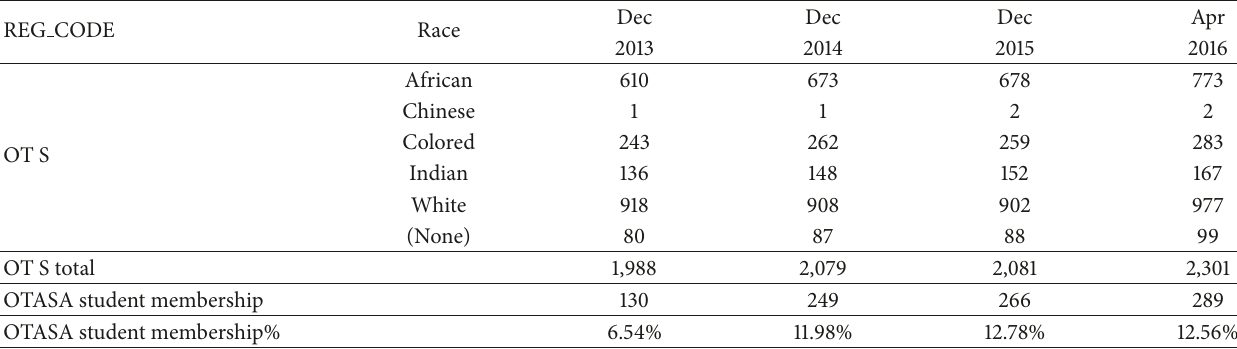
Table 1: Demographic profile of OT students (OT S) and membership in